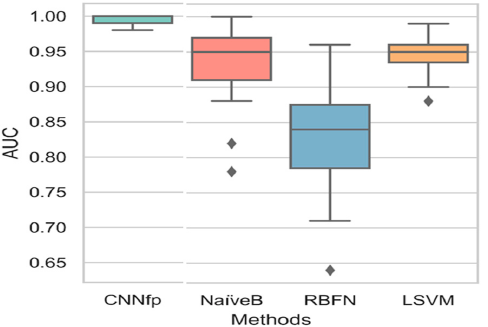
Figure 11. Boxplot chart results based on the comparison of the AUC values of different algorithms: CNNfp, NaiveB, RBFN, and LSVM.